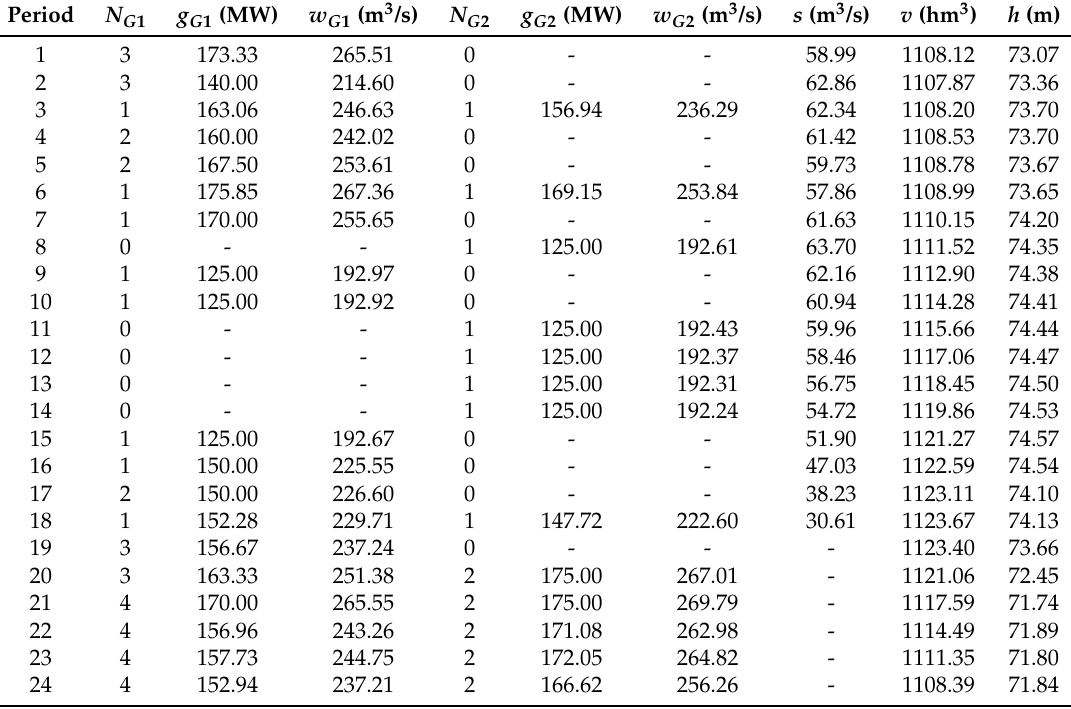
Table 11. Results with water outflow-based objective function-scenario